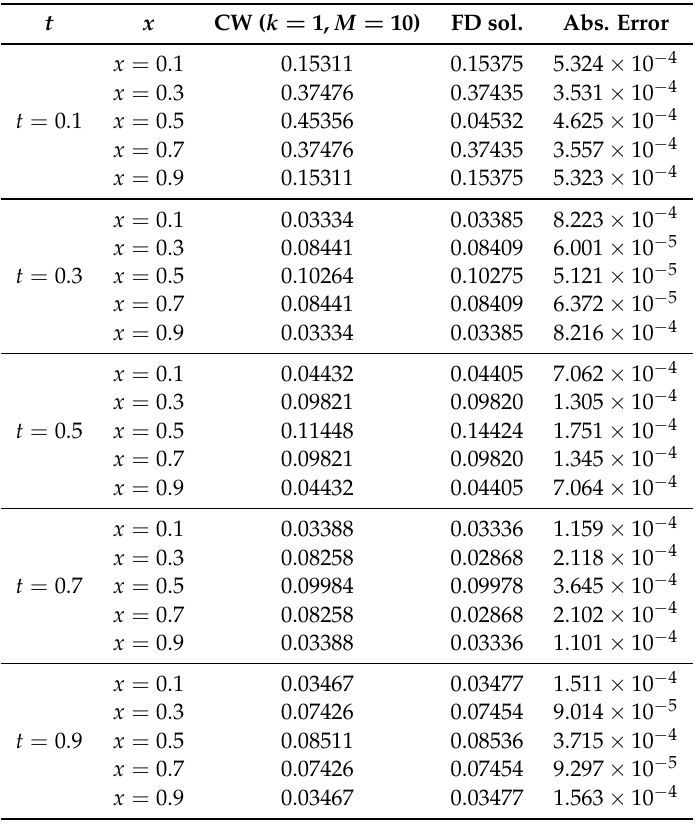
Table 2. Numerical results for α = 1 and compare with finite difference method from the MAPLE